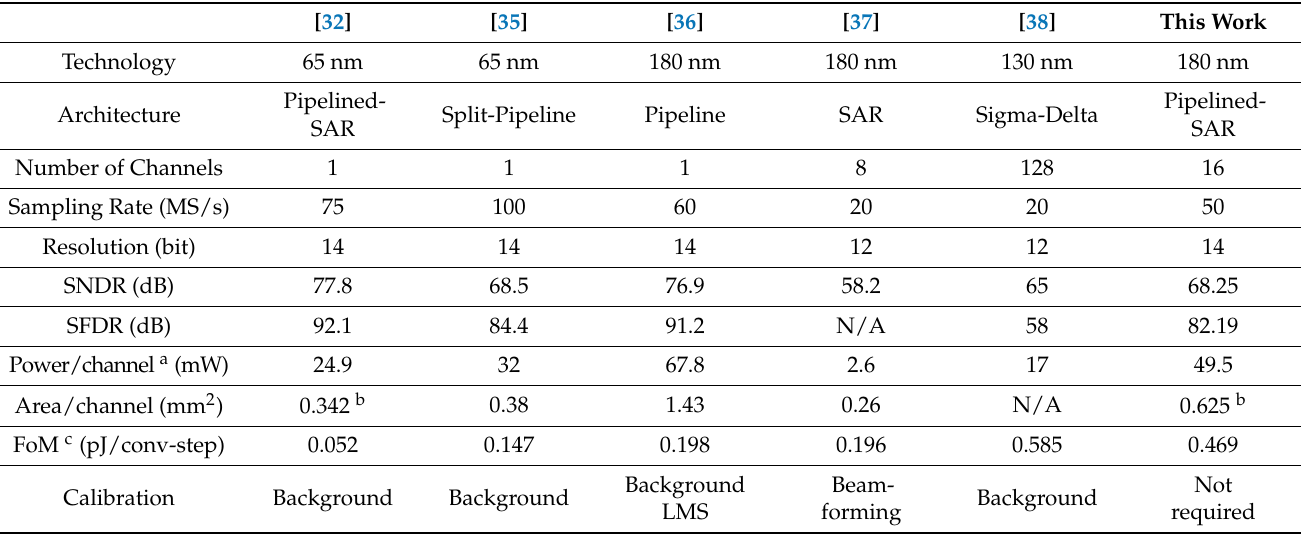
Table 3. Performance summary and